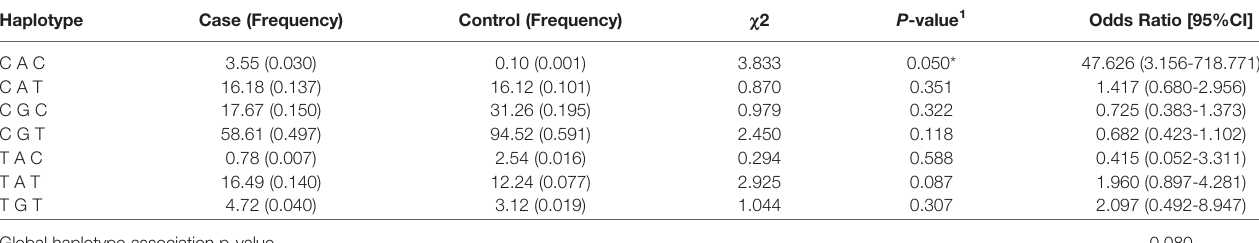
TABLE 2 | Haplotype patterns with their frequencies in the population.